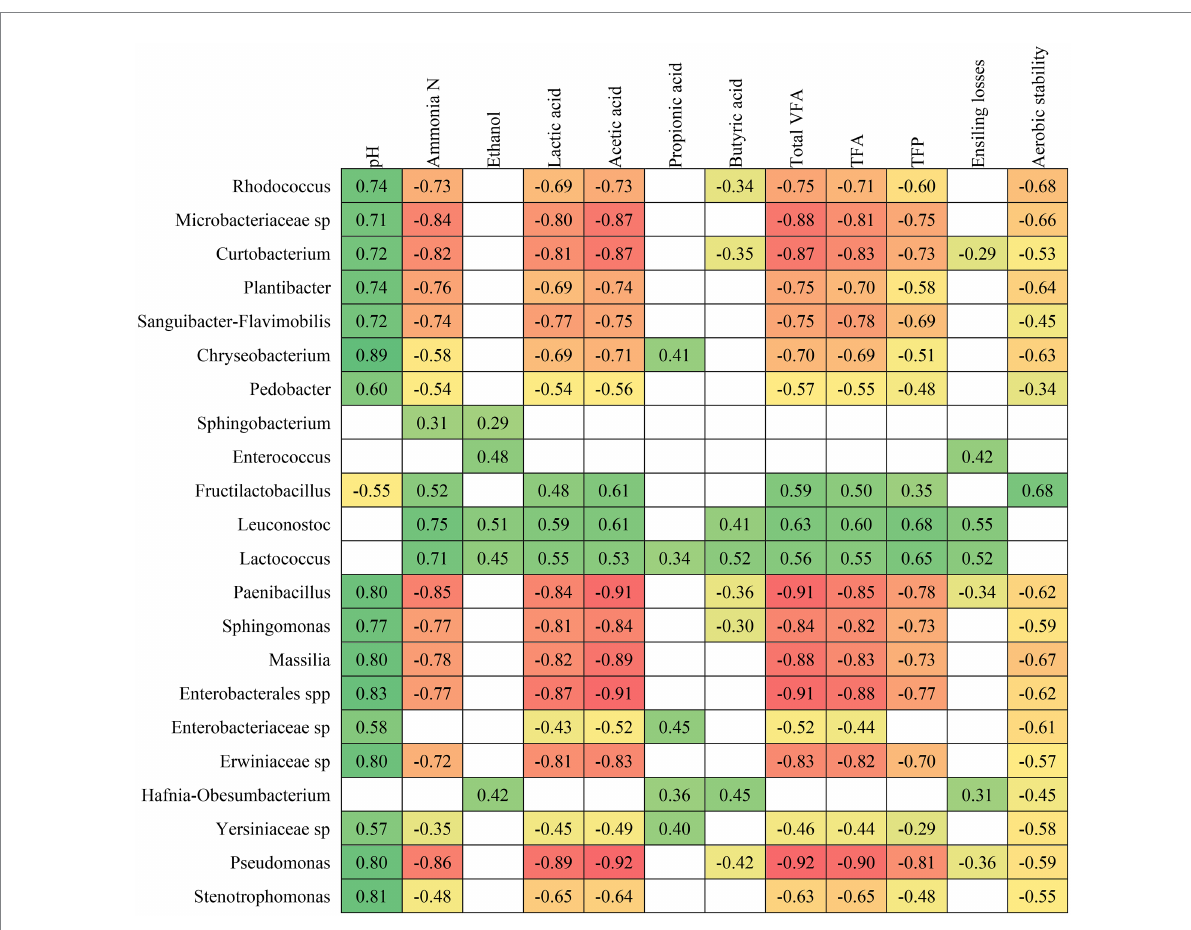
FIGURE 3 Spearman correlations between bacterial communities and preservation characteristics of crimped barley grain ensiled under different moisture content levels and treated with additives. VFA: volatile fatty acids, TFA: total fermentation acids, TFP: total fermentation products. From green (strong and positive correlation) to red colour (strong and negative correlation), while empty cells indicate a non-significant